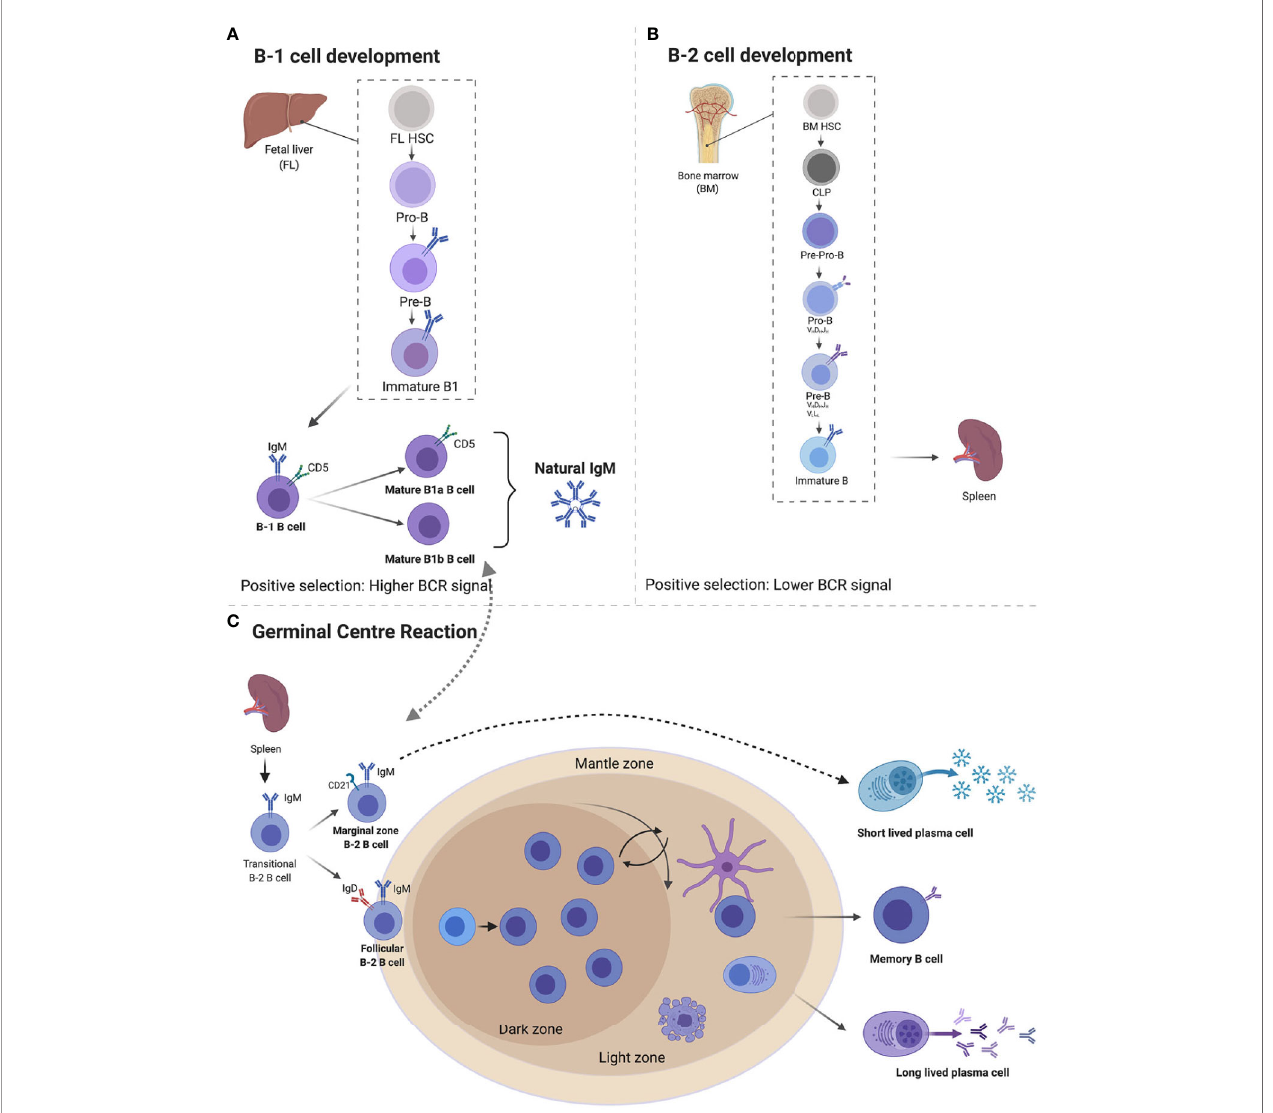
FIGURE 1 | Immunoglobulin M (IgM) developmental pathways through B1 and B2 B cells from fetal liver (FL) and bone marrow (BM). B1 cells develop FL where they go through pro-B cell, pre-B cell, immature B cell, and naïve B cells expressing IgM and CD5 which differentiates B1a and B1b cells, both capable of secreting natural IgM (A) . B2 cells develop from BM ’ s common lymphoid progenitor to become immature B cells that migrate to splenic B cells secreting IgM. Expression of IgD differentiates marginal zones vs. follicular B cells (B) . Follicular B cells upon antigen stimulation can either undergo germinal center maturation creating long-lived plasma cells, memory B cells, class switch, or remain unswitched short-lived plasma cells (C) . Created with